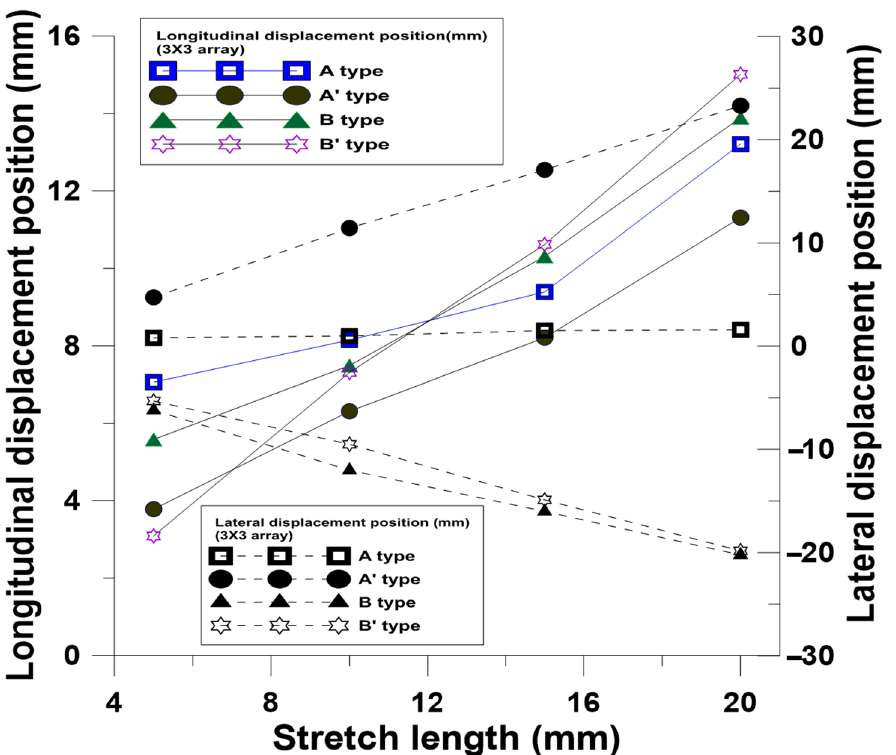
Figure 11. Relationship between changes in longitudinal displacement positions and lateral displacement positions of 3 × 3 NPR arrays at different stretching lengths.